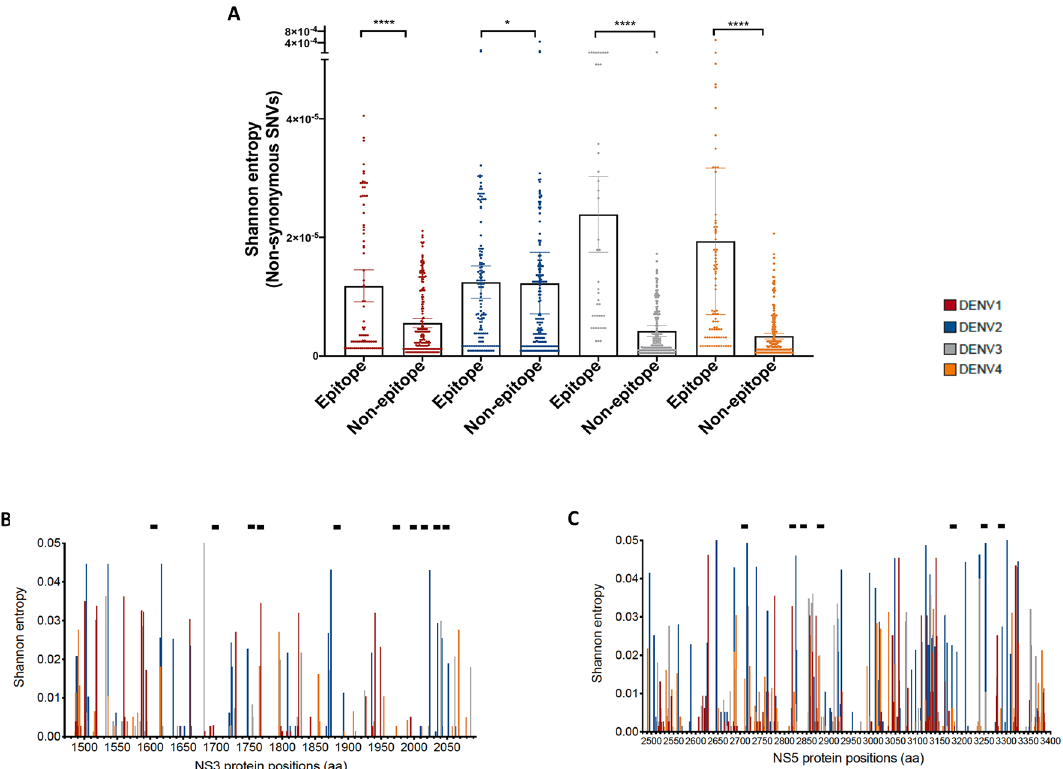
Figure 3. Viral diversity analysis revealed conserved regions within the NS3 and NS5 regions. ( A ) Distribution of Shannon entropy values within and outside epitope regions using non-synonymous SNVs. Statistical tests performed using non-parametric Mann–Whitney U test. Shannon entropy values are colour-coded by serotype. ( B , C ) Distribution of Shannon entropy values from non-synonymous SNVs within NS3 and the NS5 regions. Black bars represent the location of the selected epitopes within conserved regions of the NS3 and the NS5